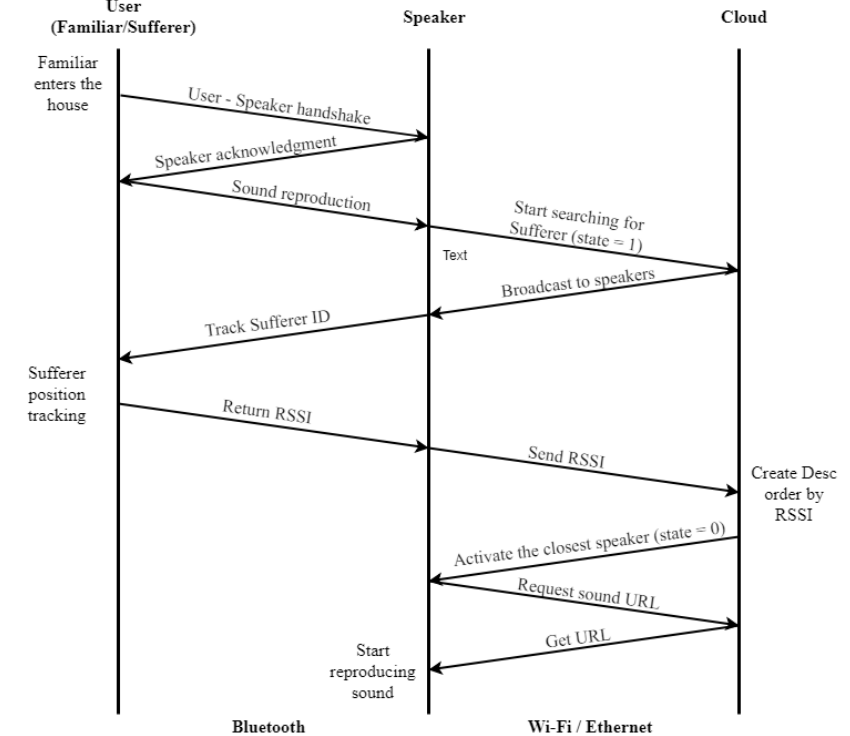
Figure 4. Communication from the entrance of a Familiar to a Sufferer’s house until the reproduction of the associated